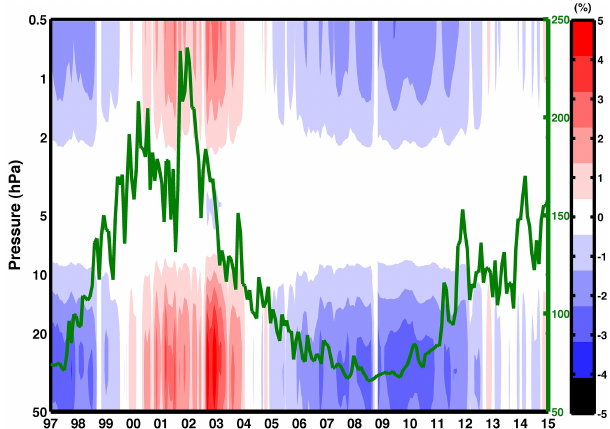
Figure 8. Amplitude of the ozone-solar F10.7 flux fitted by mul- tilinear regression for the time interval from January 1997 to Jan- uary 2015. The green line represents the time series of the monthly mean 10.7cm solar radio flux as a measure of the solar